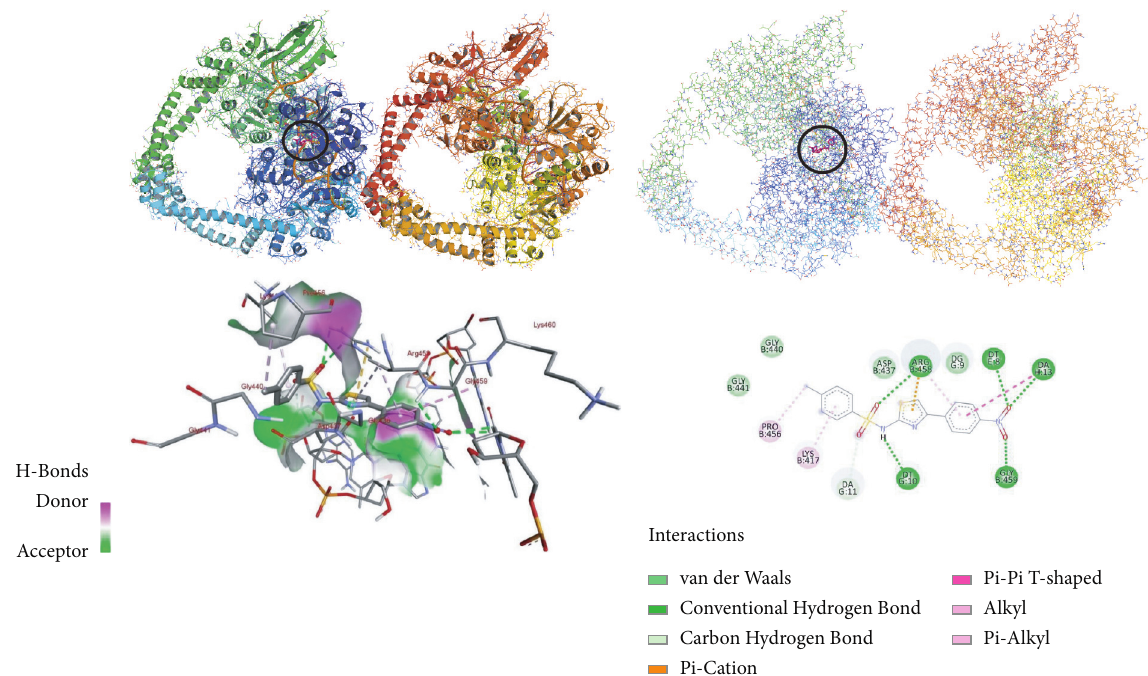
Figure 3: The 2D and 3D binding interactions of compound 11a against S. aureus gyrase (PDB ID: 2XCT). 3D ribbon and line models show the binding pocket structure of S. aureus gyrase with compound 11a . Hydrogen bonds between compounds and amino acids are shown as green dashed lines, and hydrophobic interactions are shown as pink lines. Electrostatic interaction is shown as orange line.